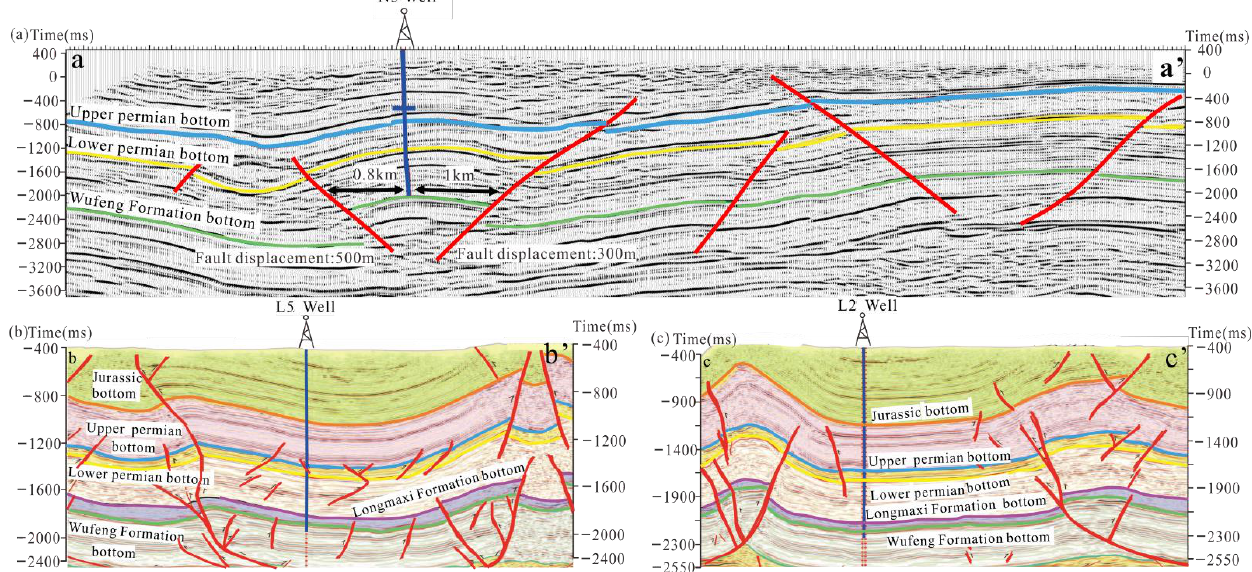
Figure 10. Seismic profiles showing that ( a ) low-resistivity shales are widely developed at the N5 Well because the L5 well is close to NE-trending faults at the Changning block, ( b , c ) faults and natural fractures are widely developed at the top of tight anticlines, decreasing the resistivity of the shale reservoir. a–c means the starts of the seismic profiles and a’–c’ means the ends of the seismic profiles. And locations of 3 seismic profiles have been marked in the Figure